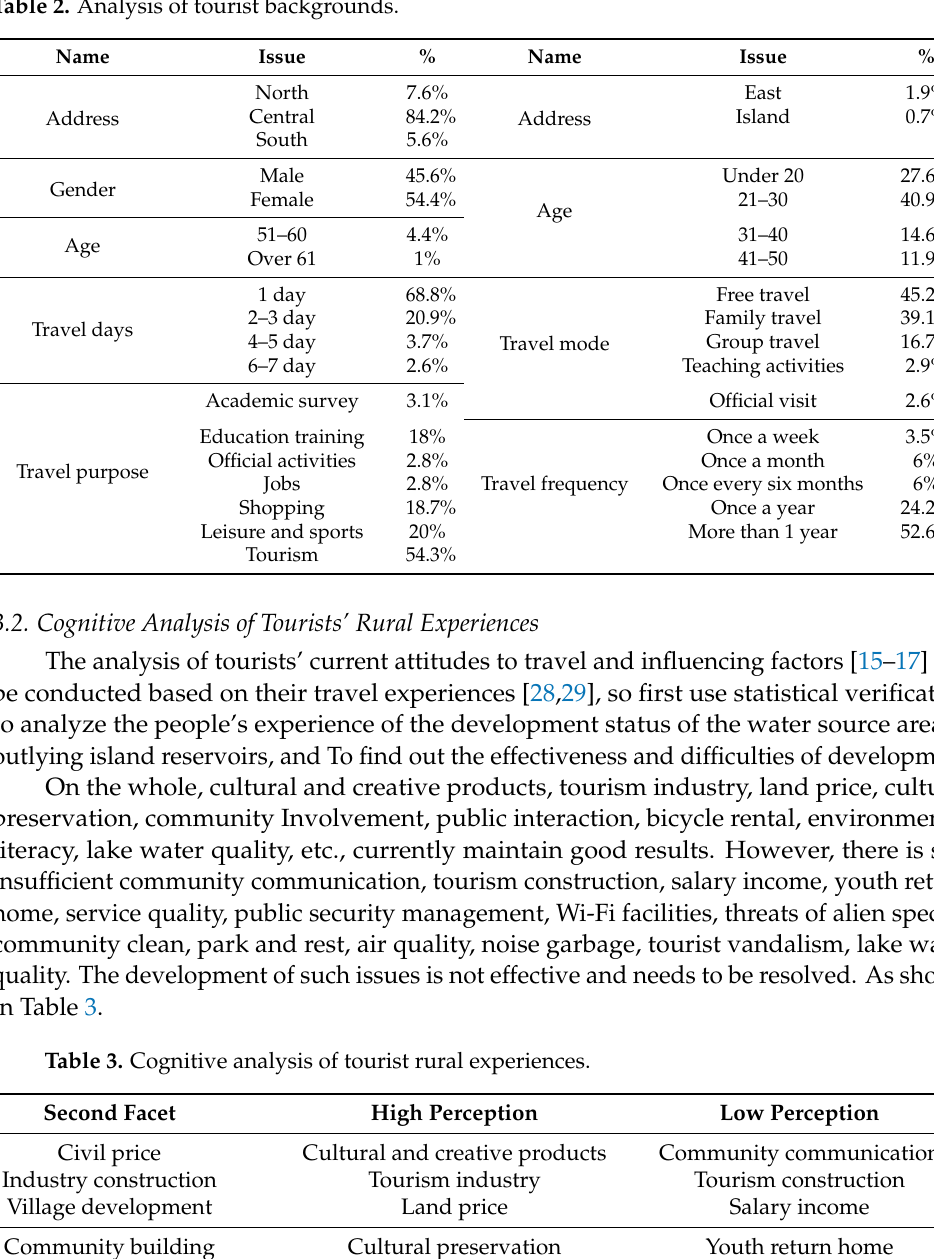
Table 2. Analysis of tourist backgrounds.